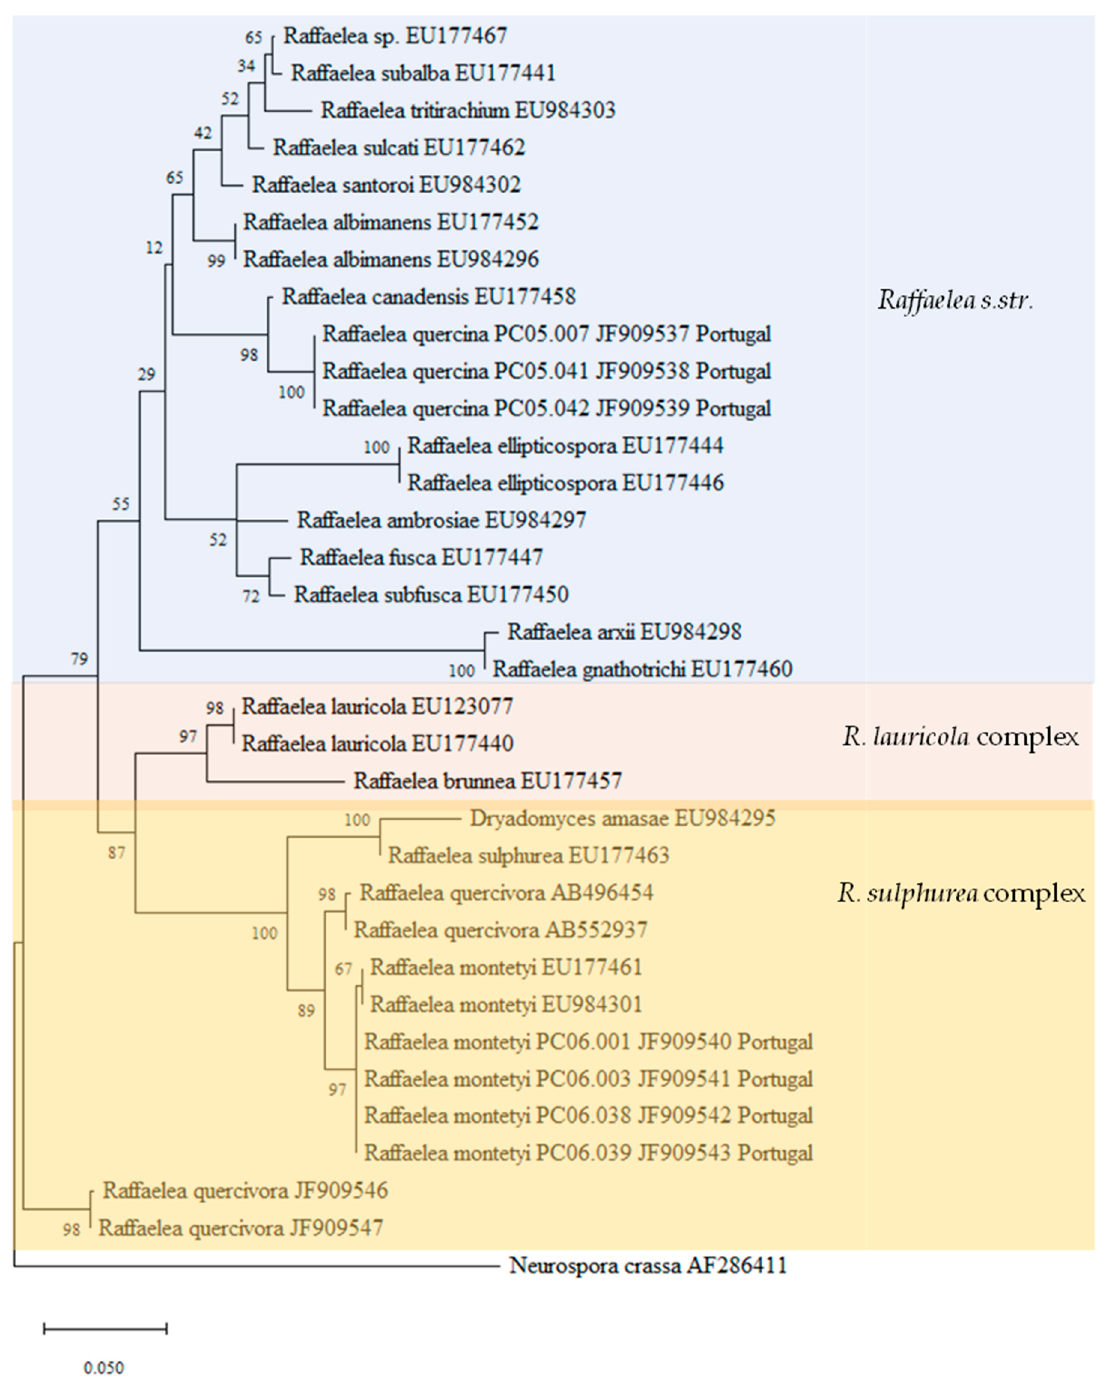
Figure 4. Phylogenetic relationships of Raffaelea isolates collected from Platypus cylindrus and its galleries on cork oak logs based on the sequence alignment of the partial sequence of the LSU region or the rDNA. The phylogram was generated by ML analyses with 1.000 bootstrap replications. Bootstrap values are indicated at the nodes. The analysis involved 34 nucleotide sequences. There were a total of 540 positions in the final dataset. Evolutionary analyses were conducted in MEGA X [37].